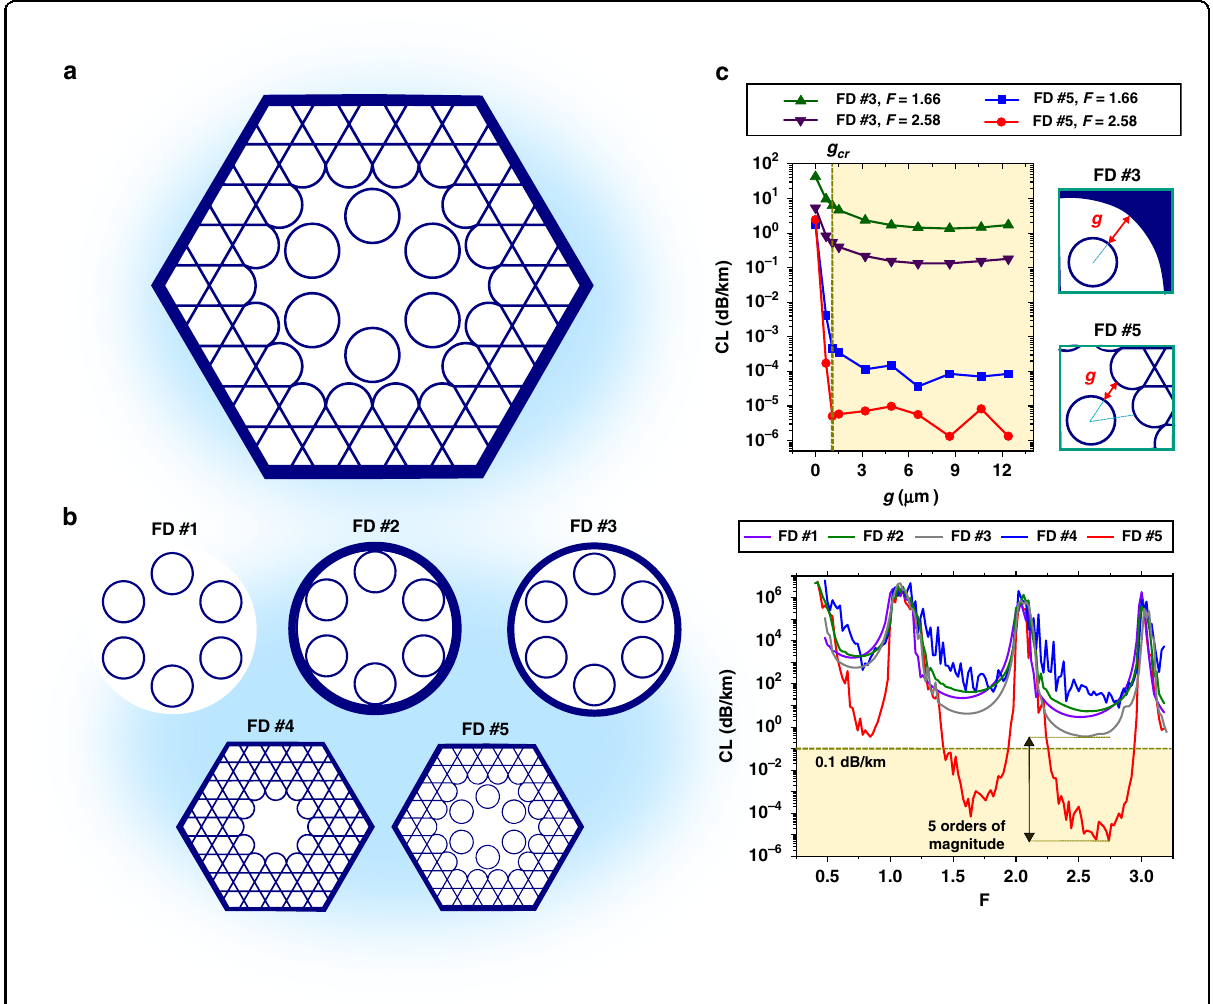
Fig. 1 Fiber design rationale. a Schematic diagram of the hybrid Kagome-tubular HCPCF. b CL simulation results for different fi bre designs (FD). FD #1: jacketless tubular lattice; FD #2: jacketed tubular lattice; FD #3: tubular lattice design with a spacing between the tubes and the silica jacket; FD #4: Kagome lattice; FD #5: hybrid lattice. c CL as a function of the distance ( g ) between the lattice tubes and the silica jacket (for FD #3) or between the lattice tubes and Kagome lattice (for FD #5) at selected normalised frequency values ( F